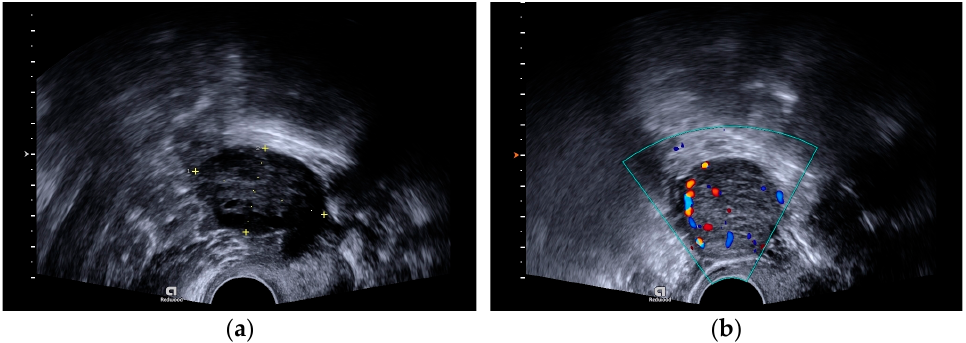
Figure 1. ( a ) A transvaginal ultrasound scan showing a polycystic structured ovary. ( b ) A transvaginal ultrasound scan showing a left ovary tumor with strong blood flow. ultrasound scan showing a left ovary tumor with strong blood